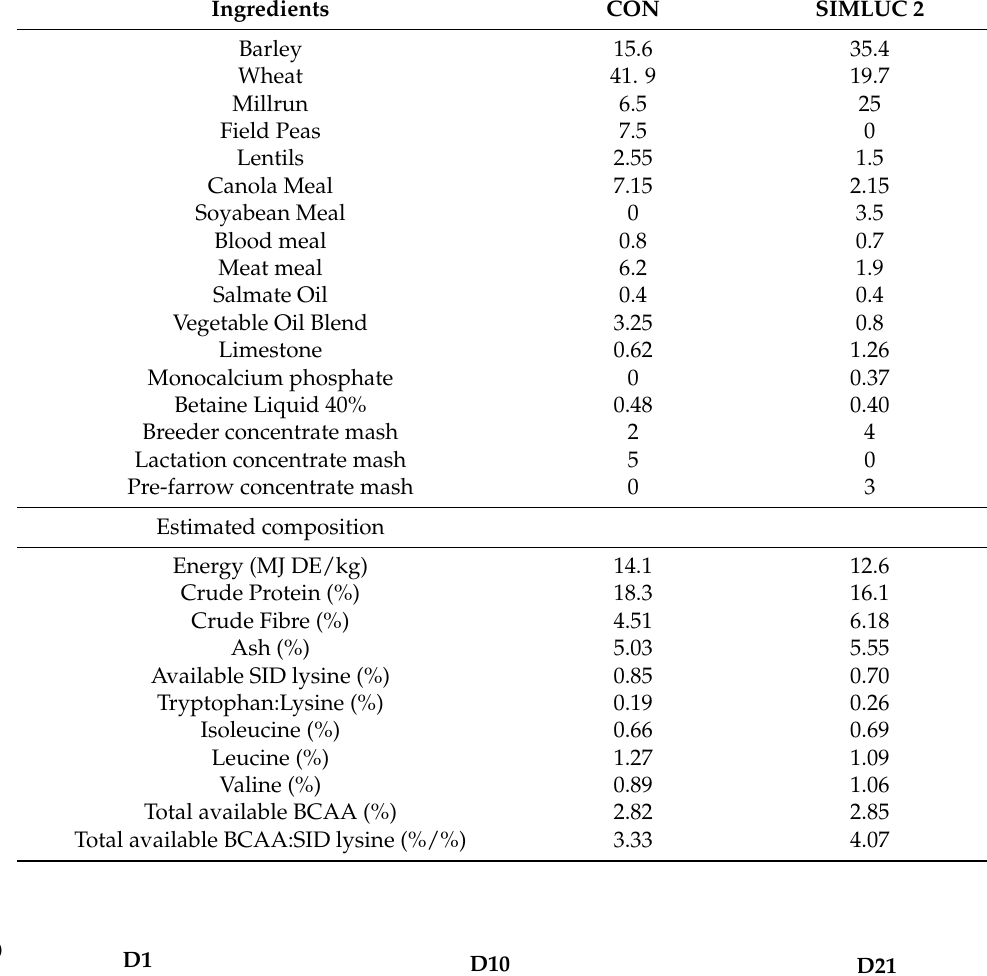
Table 2. Composition of experimental diets fed in late gestation and lactation (% as fed) in Experiment 2.